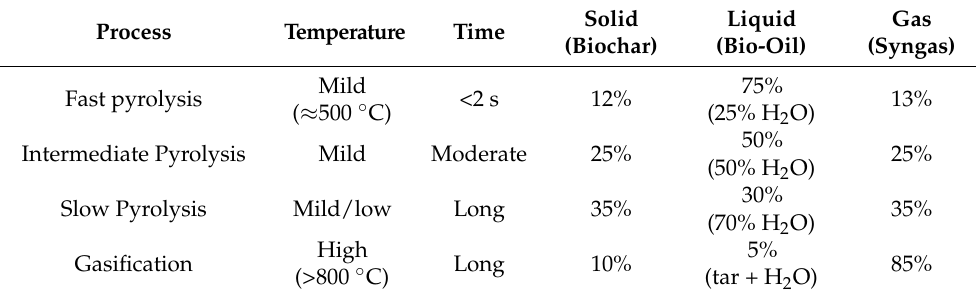
Table 2. General ratio data of different pyrolysis product distribution.